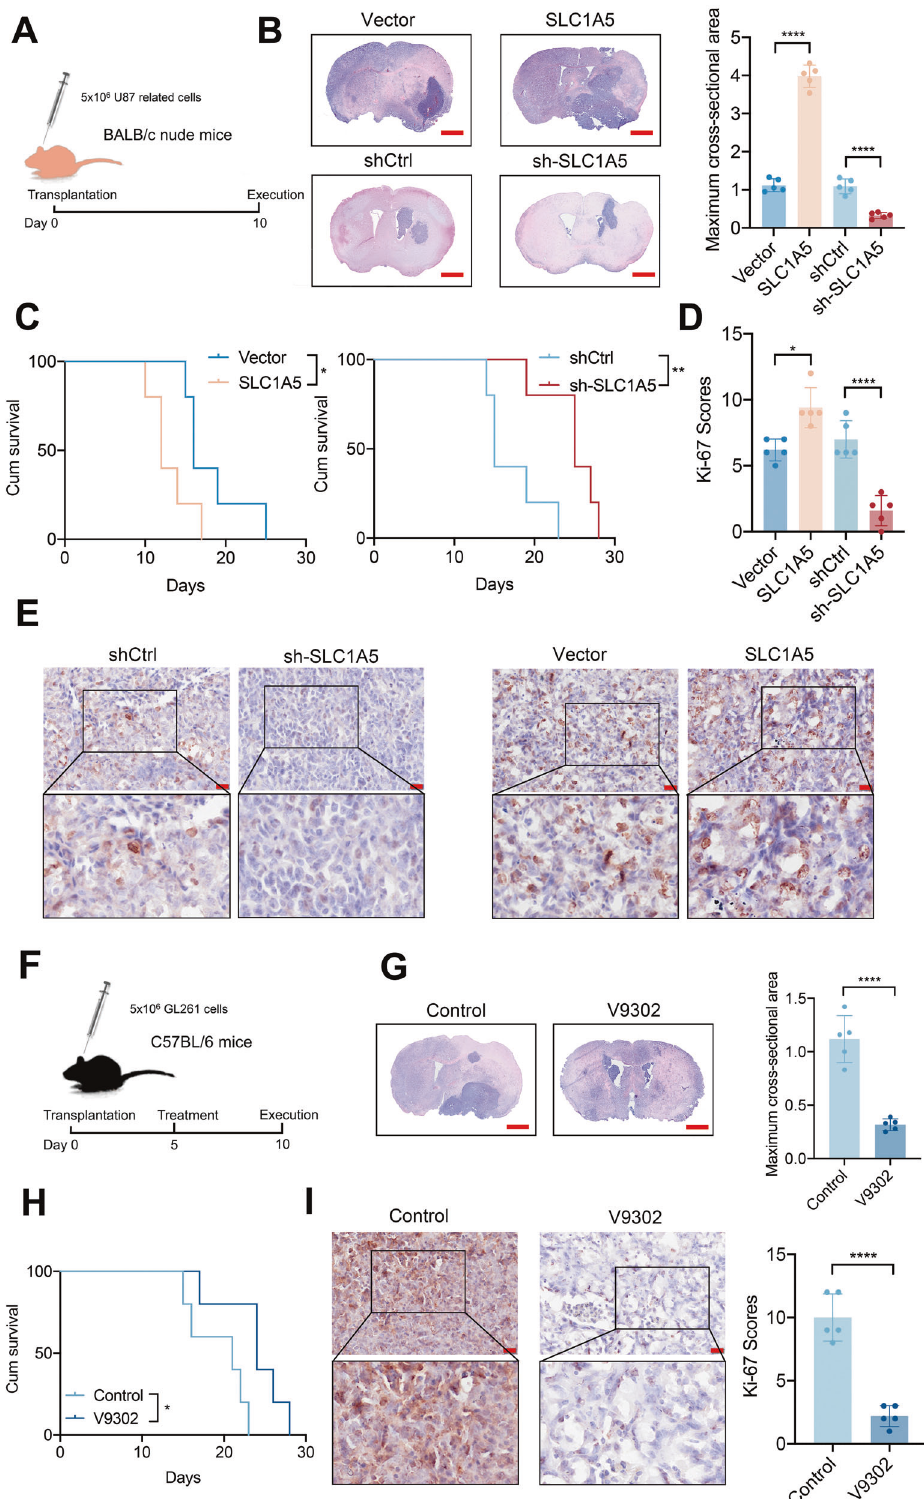
Fig. 4 SLC1A5 modulated the glioma growth in vivo. A The schematic illustration of U87 related cells transplantation in BALB/c nude mice. B The HE staining and the tumor size analysis for mice in SLC1A5 overexpression or knockdown groups (Scale Bar = 1 mm). C Kaplan – Meier survival curves of the mice survival time in SLC1A5 overexpression or knockdown groups. D The Ki-67 scores of glioma sections in SLC1A5 overexpression or knockdown groups. E The Ki-67 IHC images of glioma sections in SLC1A5 overexpression or knockdown groups (Scale Bar = 20 μ m). F The schematic illustration of V9302 treatment in GL261-bearing C57BL/6 mice. G The HE staining and the tumor size analysis for mice in the control and V9302 groups (Scale Bar = 1 mm). H Kaplan – Meier survival curves of the survival time of mice in the control and V9302 groups. I The Ki-67 IHC images and scores of glioma tissues in the control and V9302 groups (Scale Bar = 20 μ m).